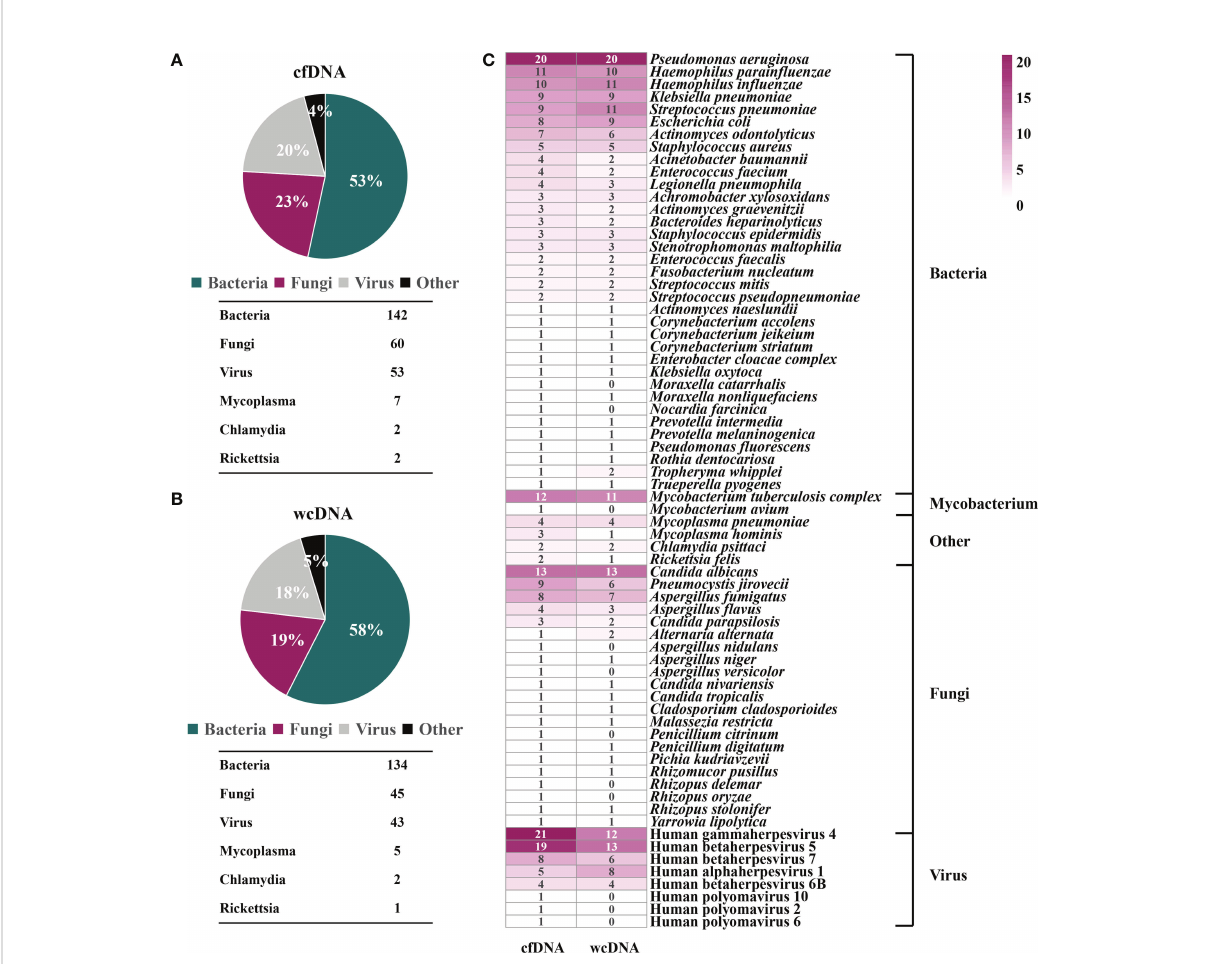
FIGURE 1 Potential pathogen pro fi les detected by mNGS of cfDNA and wcDNA. (A) , Microbial composition revealed by mNGS of cfDNA. (B) , Microbial composition revealed by mNGS of wcDNA. (C) , Comparison of mNGS using cfDNA and wcDNA in detecting microorganisms. The number in the box is the total number of patients from which some microorganism was detected.